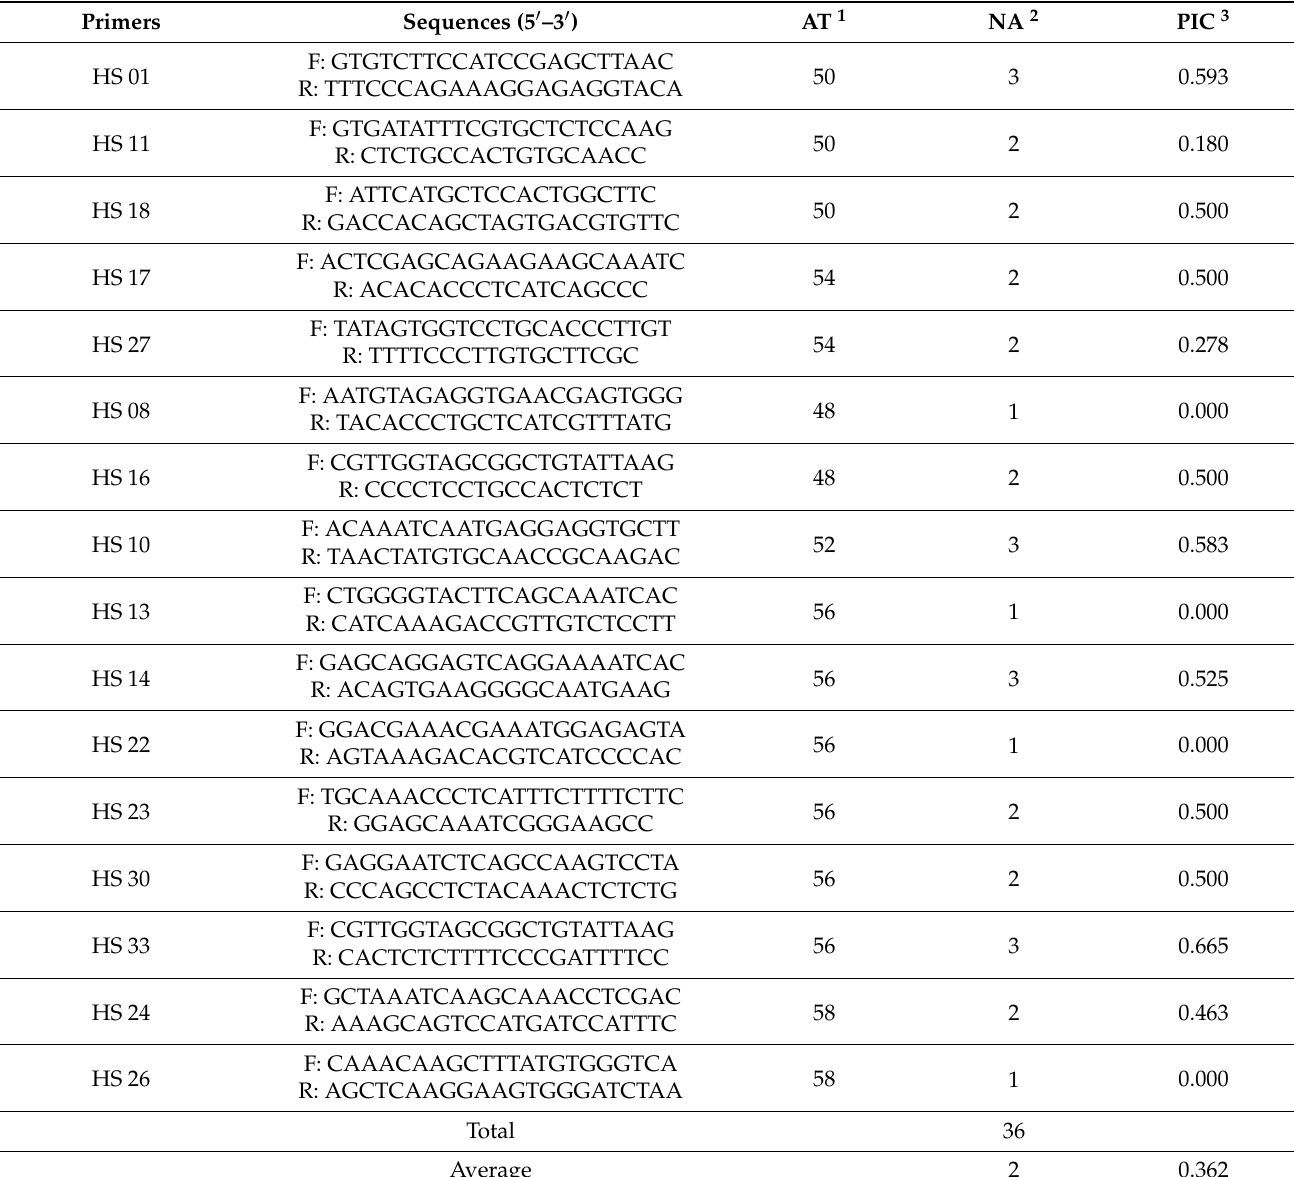
Table 2. General characteristics of SSR primers selected for evaluation of somaclonal variation and genetic diversity in Hancornia speciosa